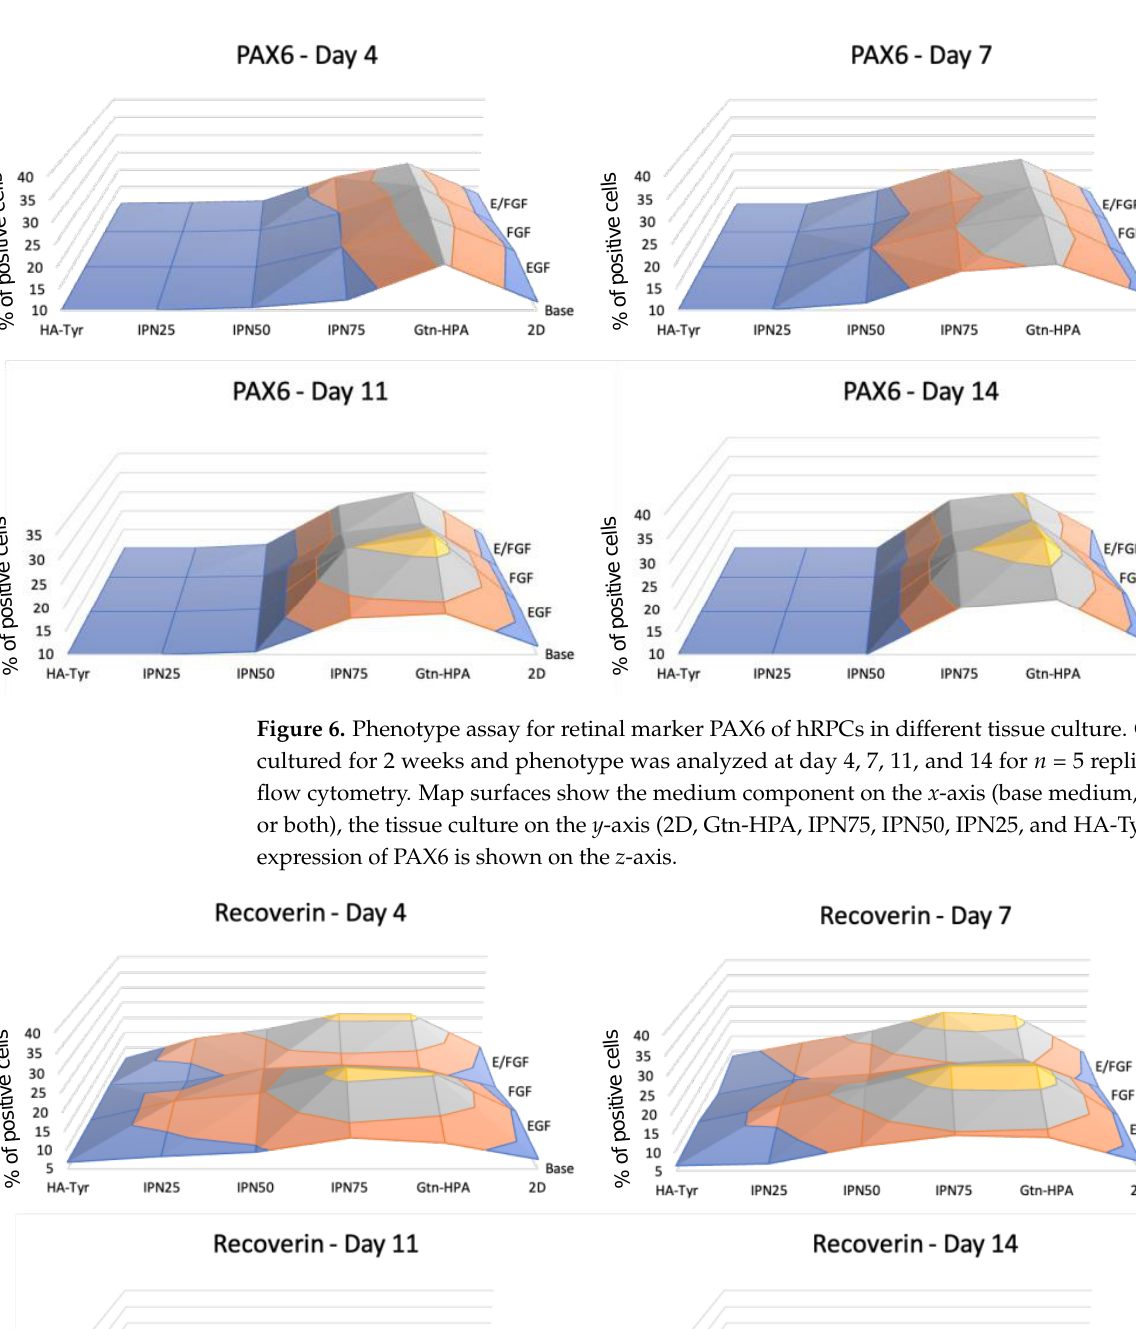
Figure 6. Phenotype assay for retinal marker PAX6 of hRPCs in different tissue culture. Cells were cultured for 2 weeks and phenotype was analyzed at day 4, 7, 11, and 14 for n = 5 replicates with flow cytometry. Map surfaces show the medium component on the x -axis (base medium, EGF, FGF, or both), the tissue culture on the y -axis (2D, Gtn-HPA, IPN75, IPN50, IPN25, and HA-Tyr) and the expression of PAX6 is shown on the z -axis.